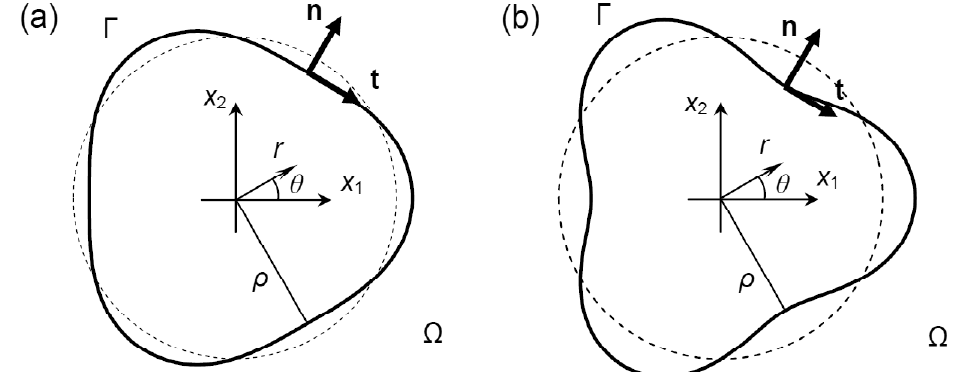
Fig. 2. Pore boundary for different values of deviation  from the unit circle: (a)  =0.1 and (b)  =0.2. Here n and t are the unit normal and tangential vectors, respectively, to the pore boundary. The Cartesian ( x and polar ( r ,  ) normalized coordinates in units R are